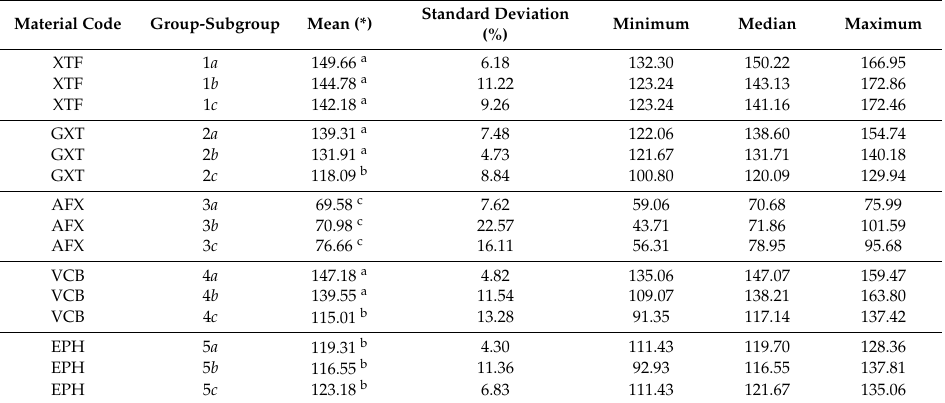
Table 2. Descriptive statistics of flexural strength (MPa) for each group/subgroup.